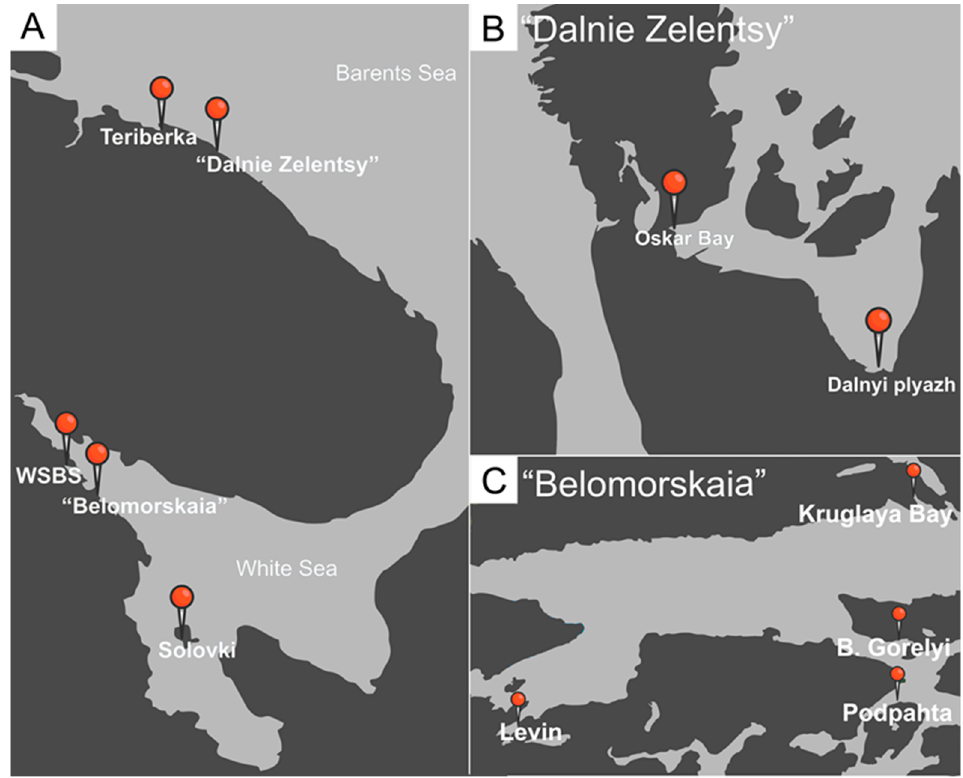
Figure 3. Location of sampling sites in the White and Barents Seas. ( A ) General map of sampling